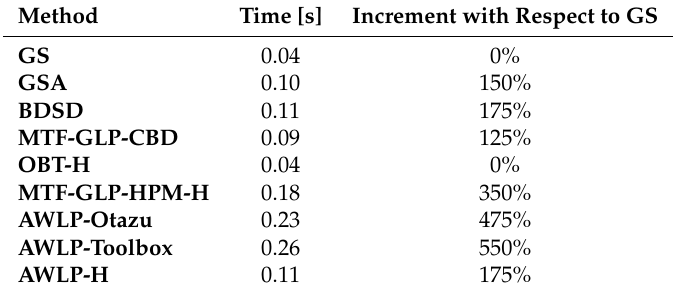
Table 5. Execution times of the pansharpening algorithms for the degraded-resolution QuickBird Trento dataset, run over an Intel(R) Core(TM) i7-7700HQ @2.80 GHz processor. The increments with respect to the fastest approach (i.e., GS) are also reported.